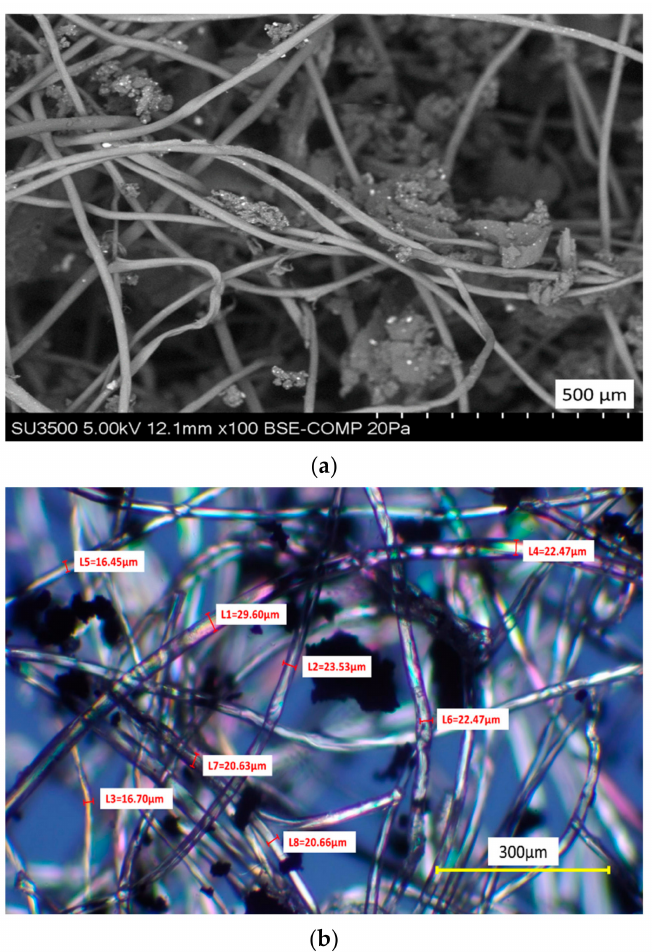
Figure 6. Morphological characterization of the PFELT: ( a ) SEM; ( b ) polarized light